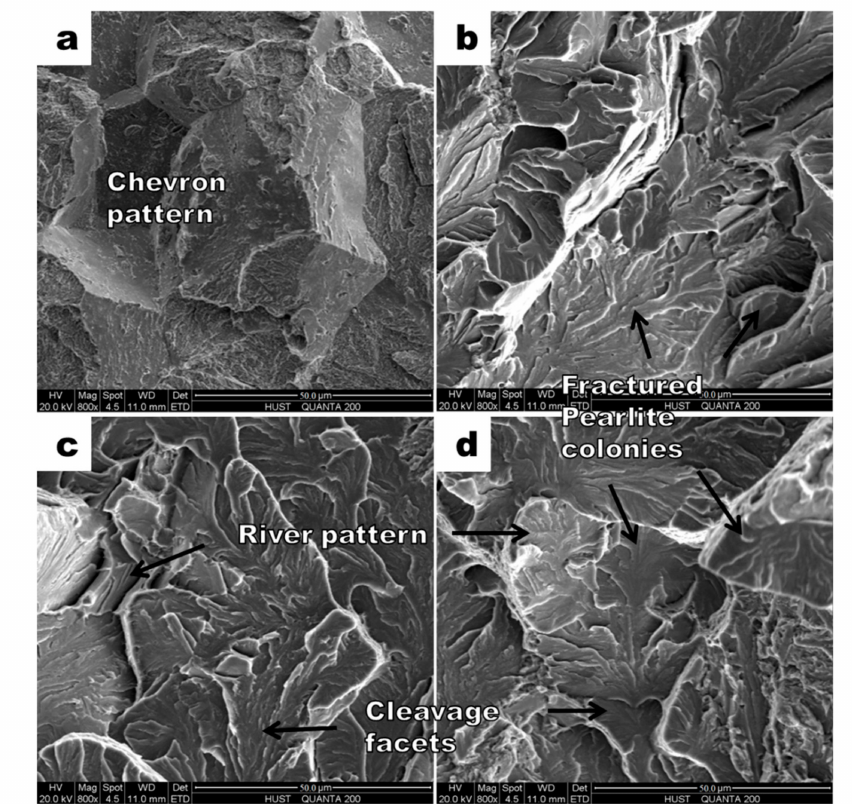
Figure 15. Field emission scanning electron microscope (FESEM) fractographs at di ff erent cooling rates. ( a ) 6 ◦ C / s. ( b ) 4 ◦ C / s. ( c ) 2 ◦ C / s. ( d ) 1 ◦ C /